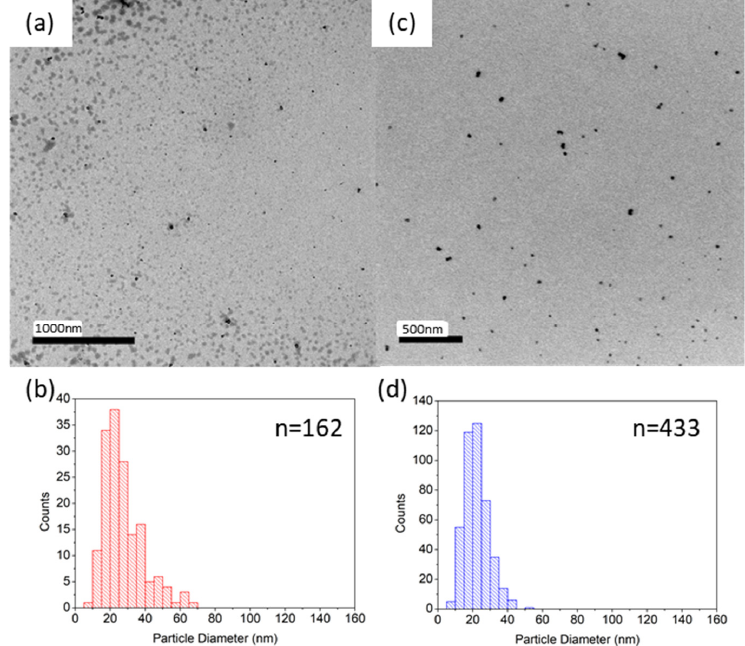
Figure 4. ( a ) Representative TEM image for compound 1-BM10 : additional images available in Supplementary Materials. ( b ) Particle length distribution for compound 1-BM10 , where n = 162. ( c ) Representative TEM image for compound 1-BM90 : additional images available in the Supplementary Materials. ( d ) Particle length distribution for compound 1-BM90 , where n = 433.